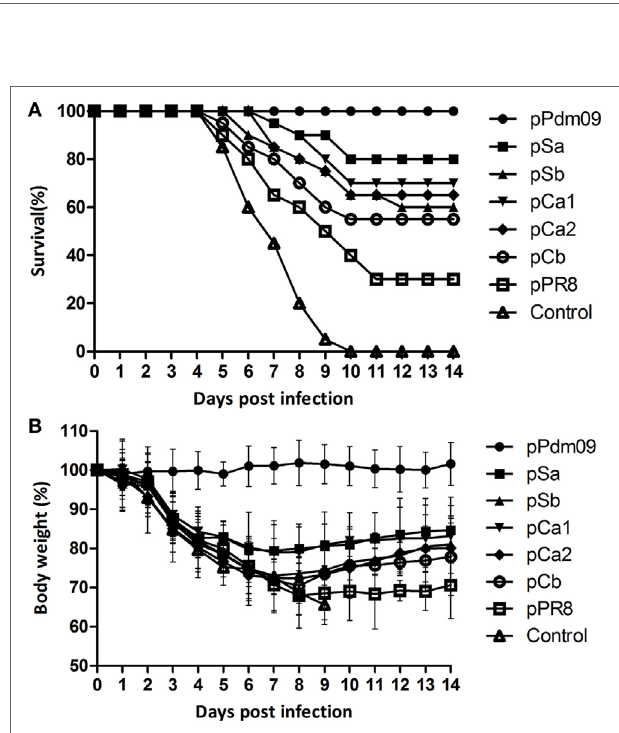
FigUre 2 | Survival and body weight of mice immunized with plasmid DNAs substituted with one epitope of the Pdm09 HA. Female BALB/c mice (6–8 weeks old) were immunized twice, at an interval of 3 weeks, with 30 µg of plasmid DNAs substituted with one epitope of the Pdm09 HA. Two weeks after the boost, the mice were challenged with a lethal dose (20 × MLD 50 ) of mouse-adapted Pdm09 virus and were monitored for survival and body weight for 14 days, (a) Survival, (B) body weight; error bars show SD of each group.